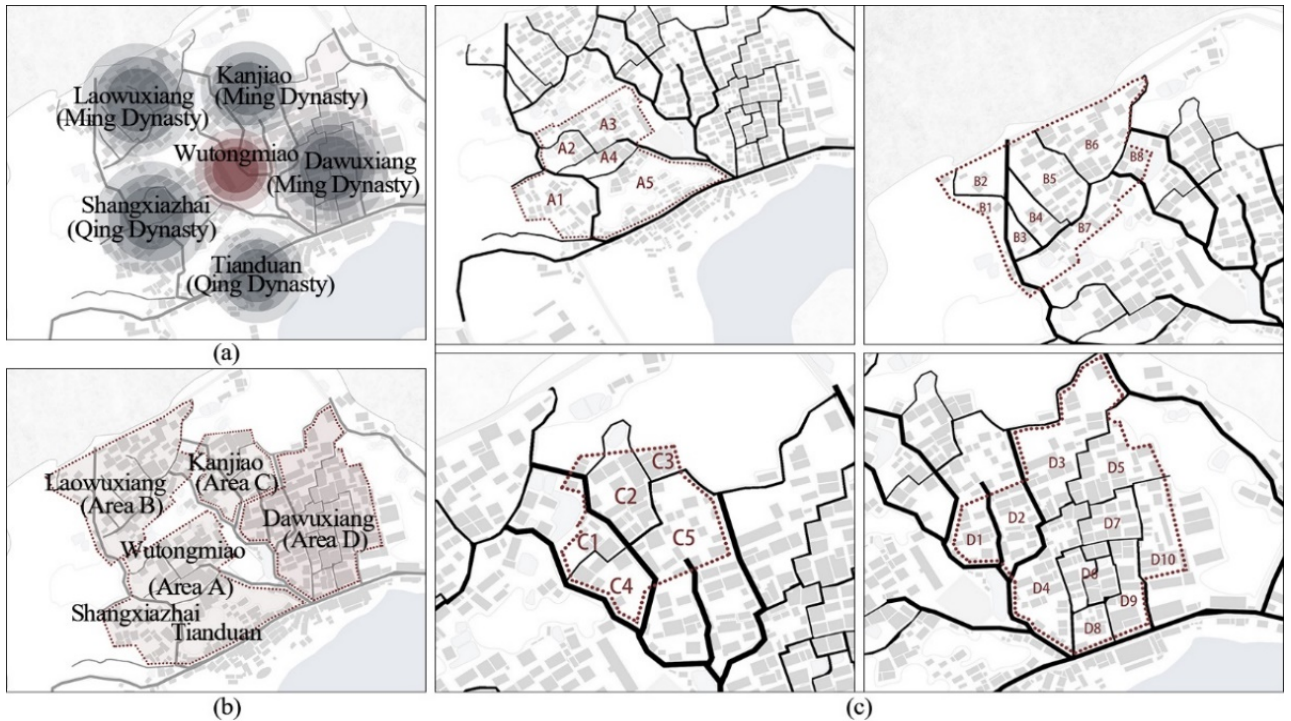
Figure 4. ( a ) The layout of the Wutongmiao, Laowuxiang, Kanjiao, Dawuxiang, Tianduan, and Shangzhai housing clusters; ( b ) class I fire-protection group zoning; and ( c ) secondary fire-protection group zoning.